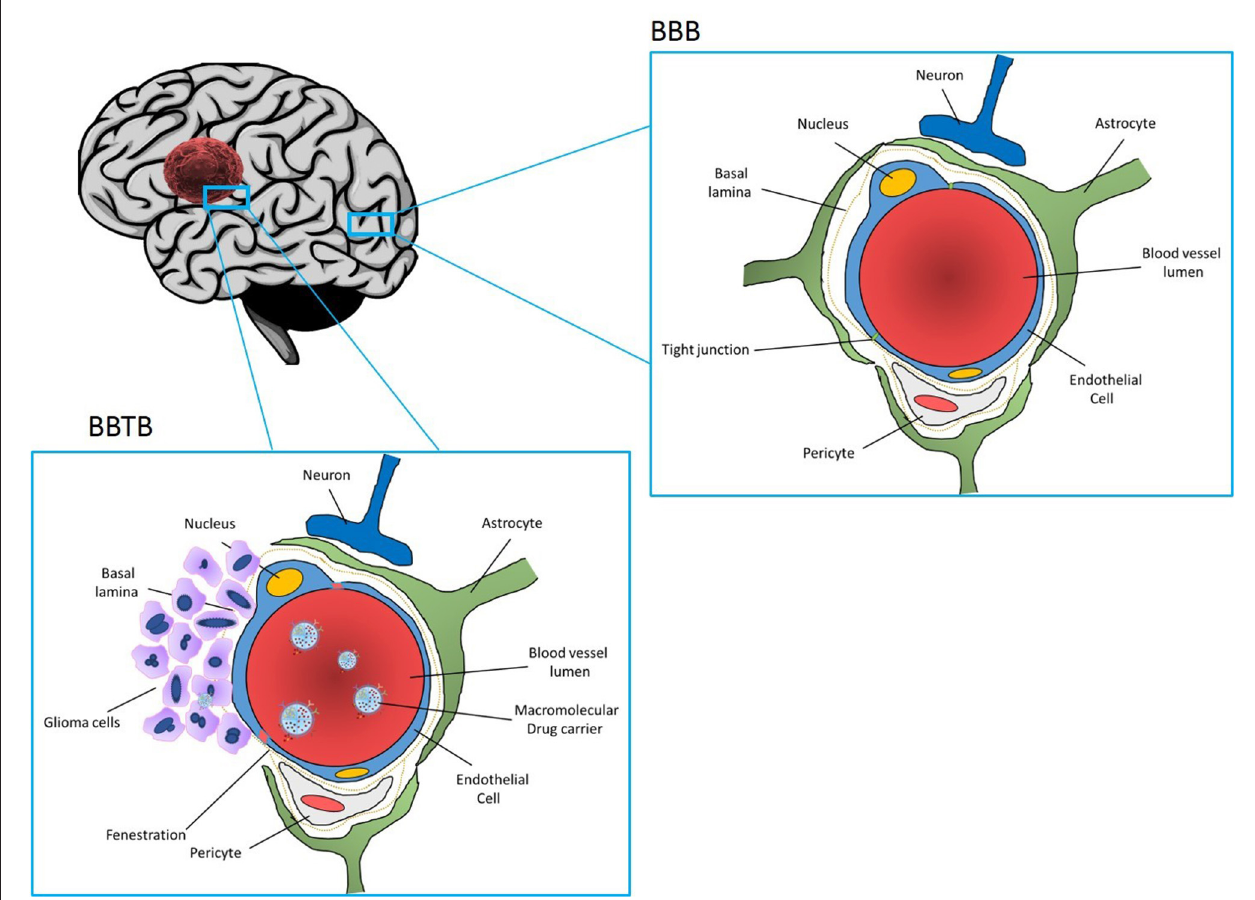
FIGURE 1 | Section of the brain showing normal part of the brain and blood brain barrier (BBB) (upper figure), and part of the brain infiltrated with GBM Blood vessels are enclosed by endothelial cells connected with tight junctions which seal the intercellular space and prevent entrance of drugs from the blood stream to the brain. BBB is further reinforced with a basal lamina. While basal lamina is disrupted by GBM tumor cells (figure the left), endothelial cells are still present forming blood brain tumor barrier (BBTB). Nanoparticles loaded with drugs and coated with receptors specific to the tumor vasculature and glioma cells can interact with the BBTB allowing for transcytosis and delivery of the drugs to GBM tumor